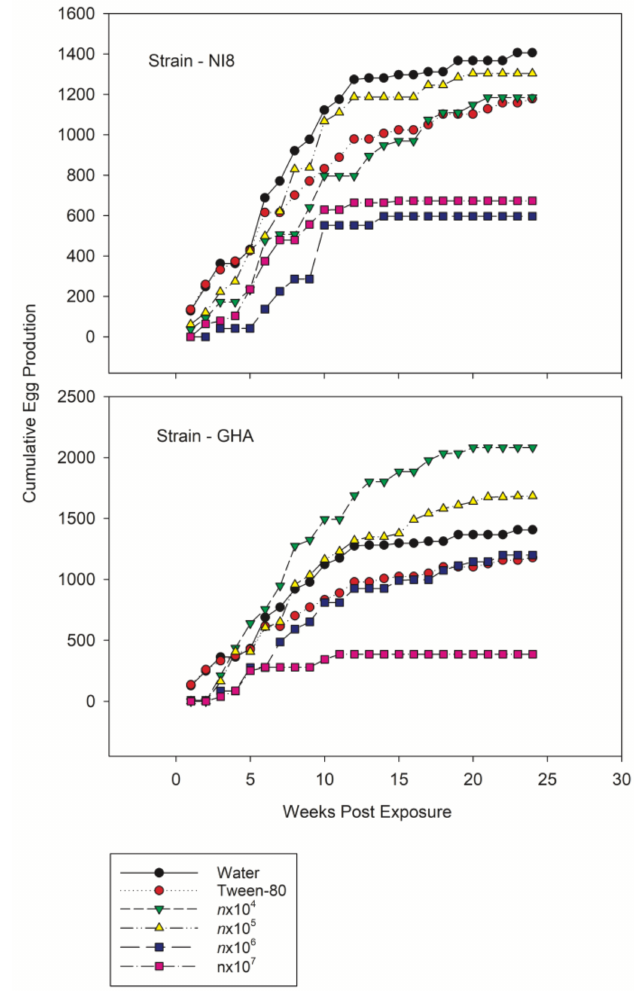
Figure 4. Cumulative egg masses production/couple/life reproduction of Nezara viridula exposed to 2 strains of Beauveria bassiana NI8 and GHA at different